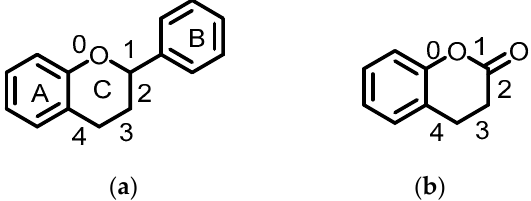
Figure 4. The backbones of flavonoids ( a ) and coumarins ( b ), and their potential cleavage bones marked with numbers. A, ring A; B, ring B; C, ring C.